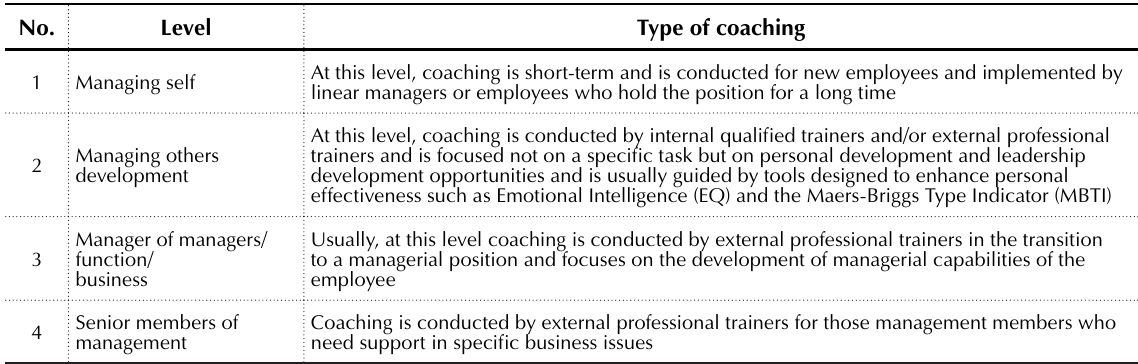
Source: Coaching policy of the Central Bank of